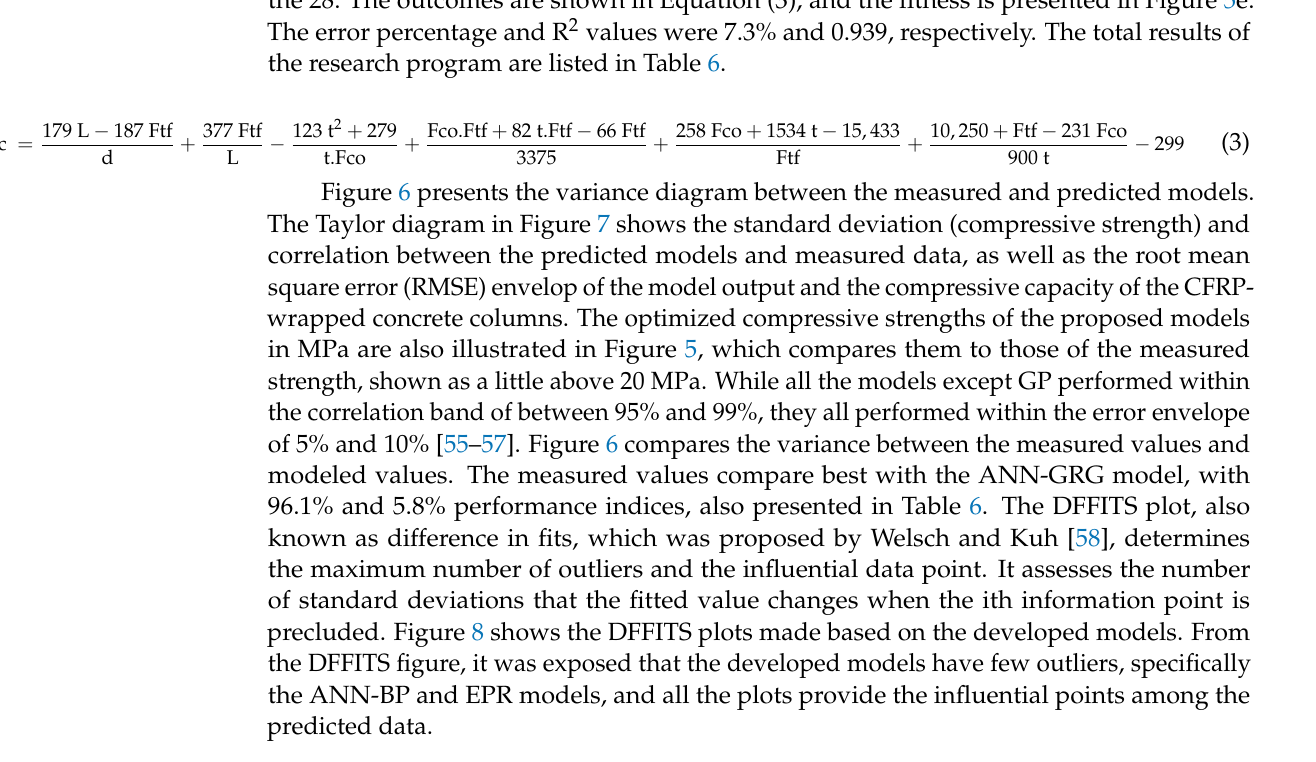
Table 6. Summary of the developed models’